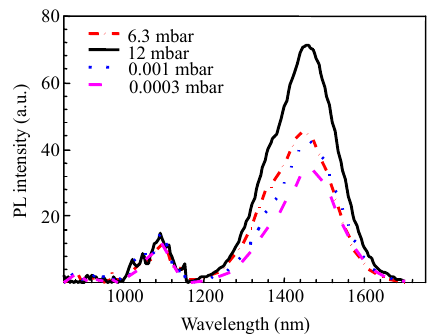
Fig. 5 PL spectra of BQDs and SQDs with different vacuums.